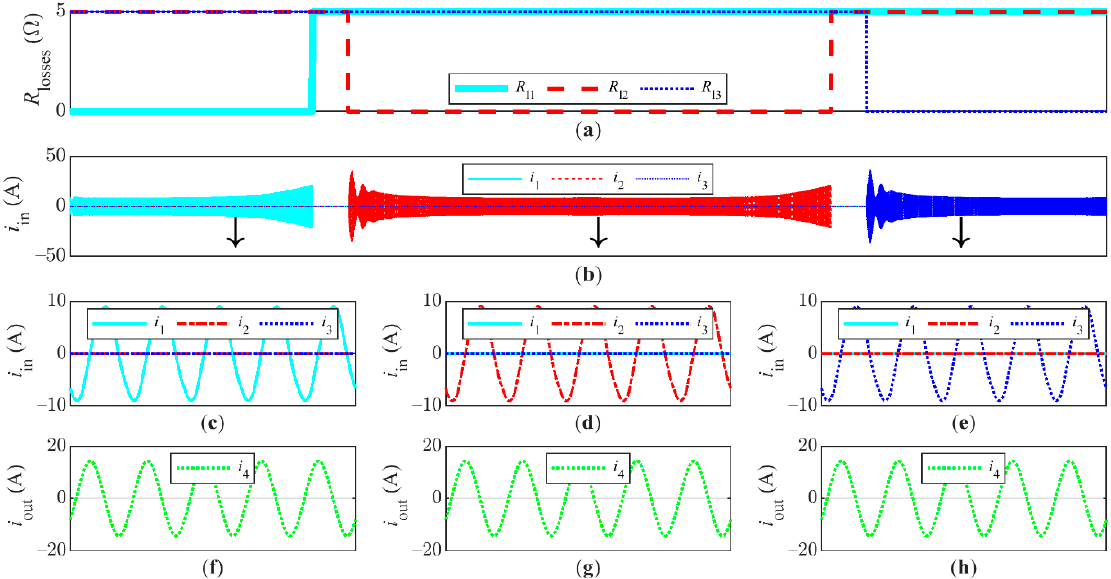
Figure 7. Simulation results of transmitter coil activation: ( a ) losses due to resistor R l 1 , R l 2 and R l 3 values; ( b ) input currents i 1 , i 2 and i 3 ; ( c ) input currents i 1 , i 2 and i 3 for the first coil activated; ( d ) input currents i 1 , i 2 and i 3 for the second coil activated; ( e ) input currents i 1 , i 2 and i 3 for the third coil activated; ( f ) output current i 4 for the first coil activated; ( g ) output current i 4 for the second coil activated; ( h ) output current i 4 for the third coil activated.